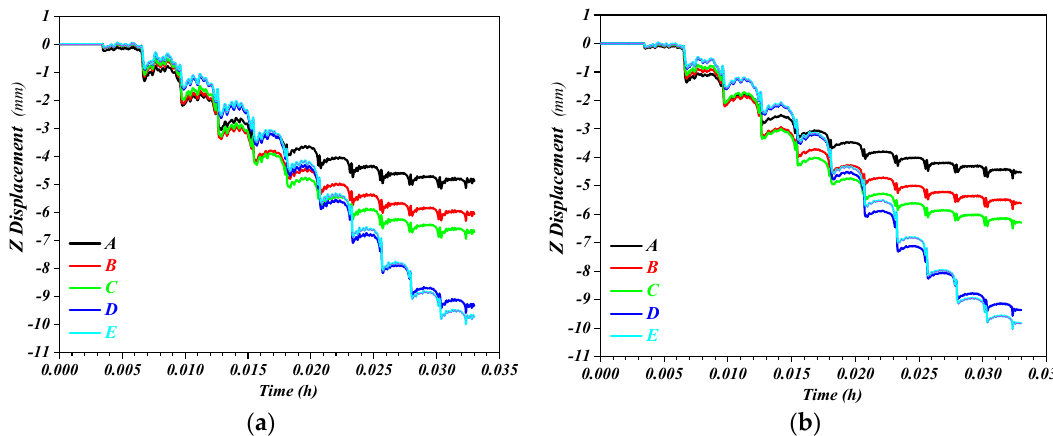
Figure 15. Displacement time history diagram of titanium plate and perforated titanium sheet A to E element. ( a ) titanium plate. ( b ) perforated titanium sheet.